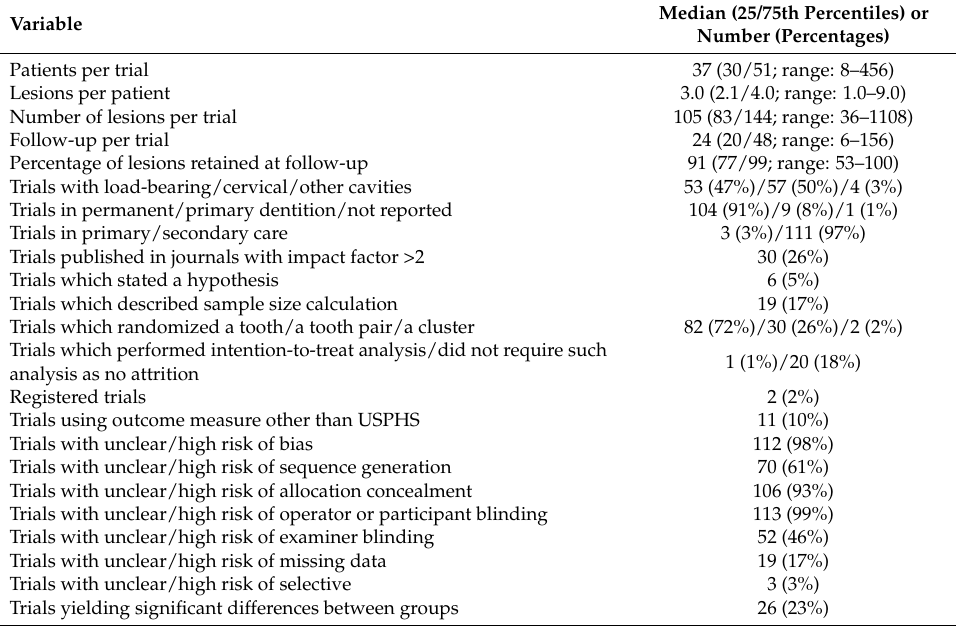
Table 1. Properties of randomized controlled trials on dental restorative materials published